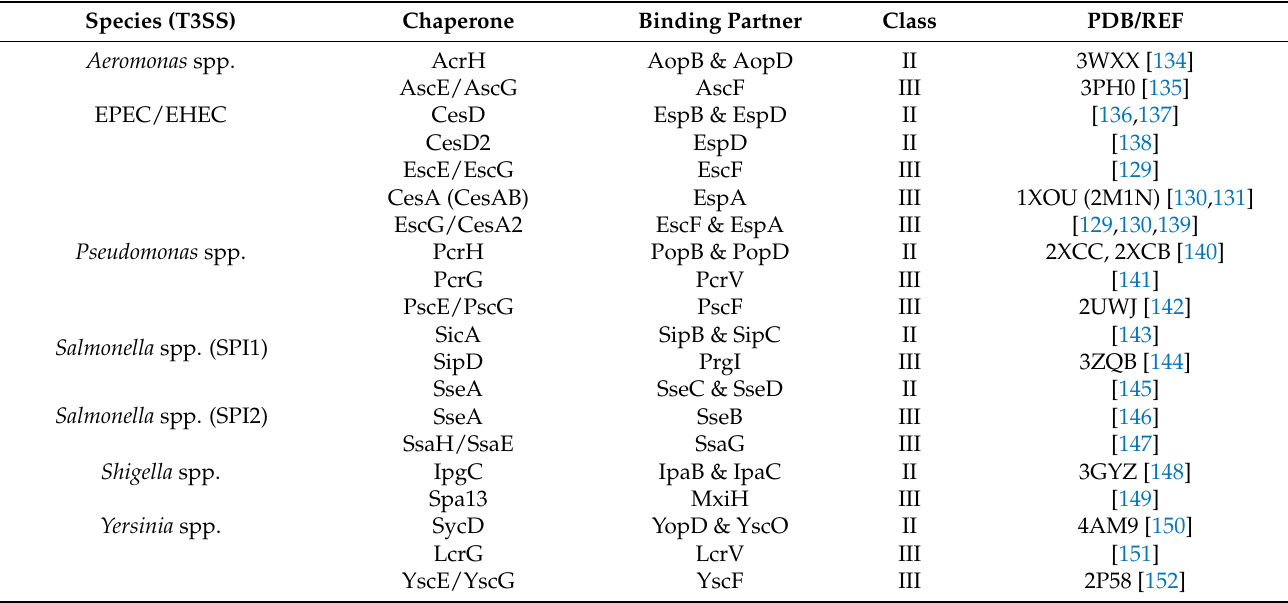
Table 2. Select class II and III